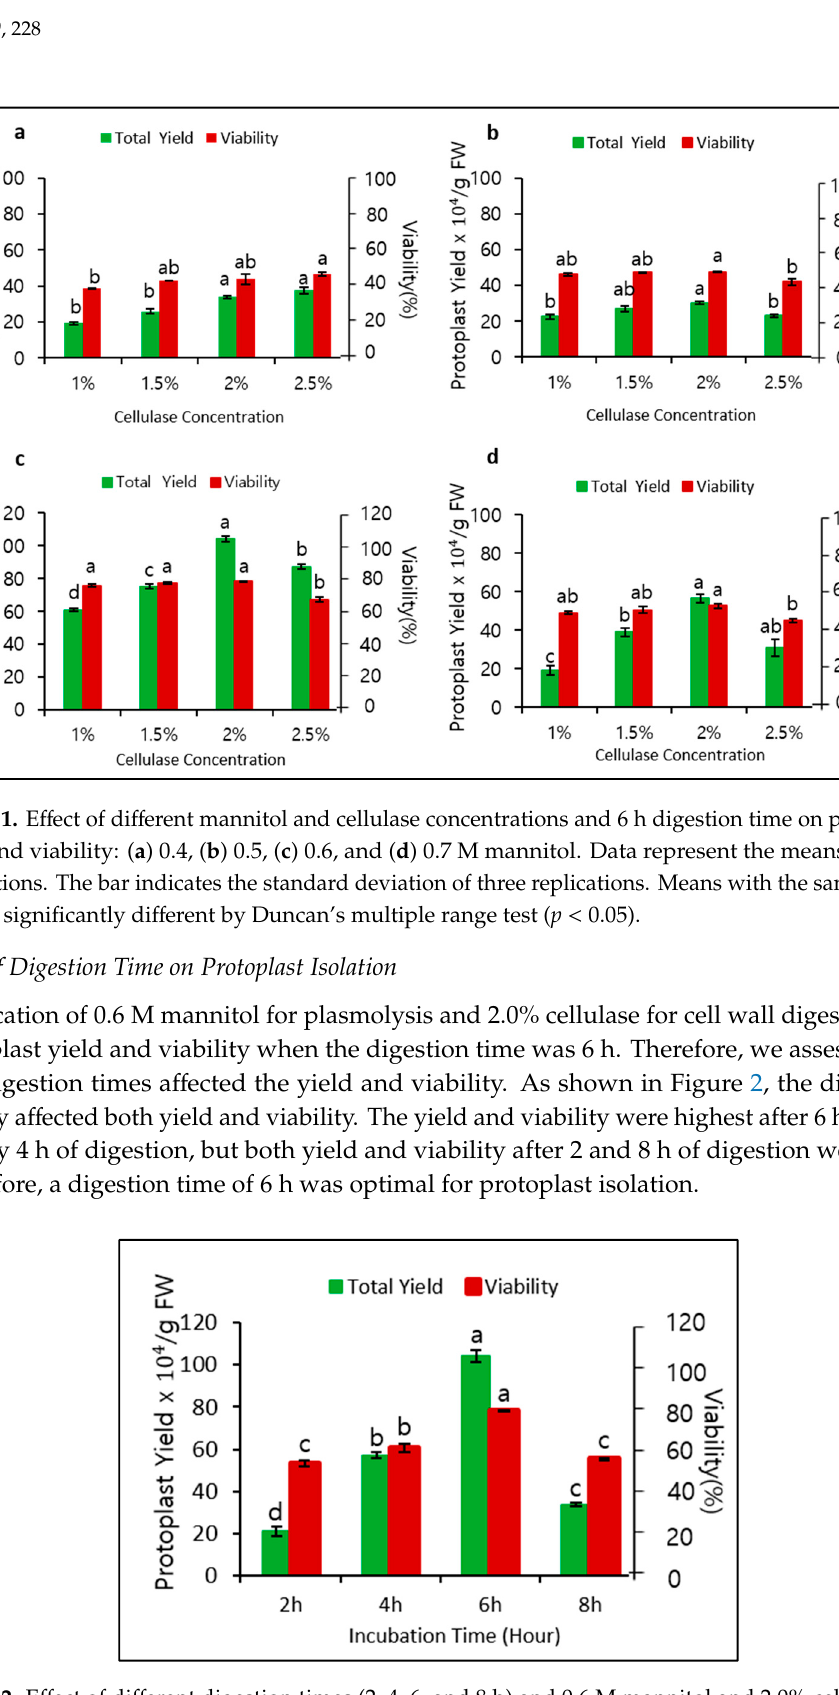
Figure 2. Effect of different digestion times (2, 4, 6, and 8 h) and 0.6 M mannitol and 2.0% cellulase on protoplast yield and viability. Data represent the means of three replications. The bar indicates the standard deviation of three replications. Means with the same letters are not significantly different by Duncan’s multiple range test ( p < 0.05).